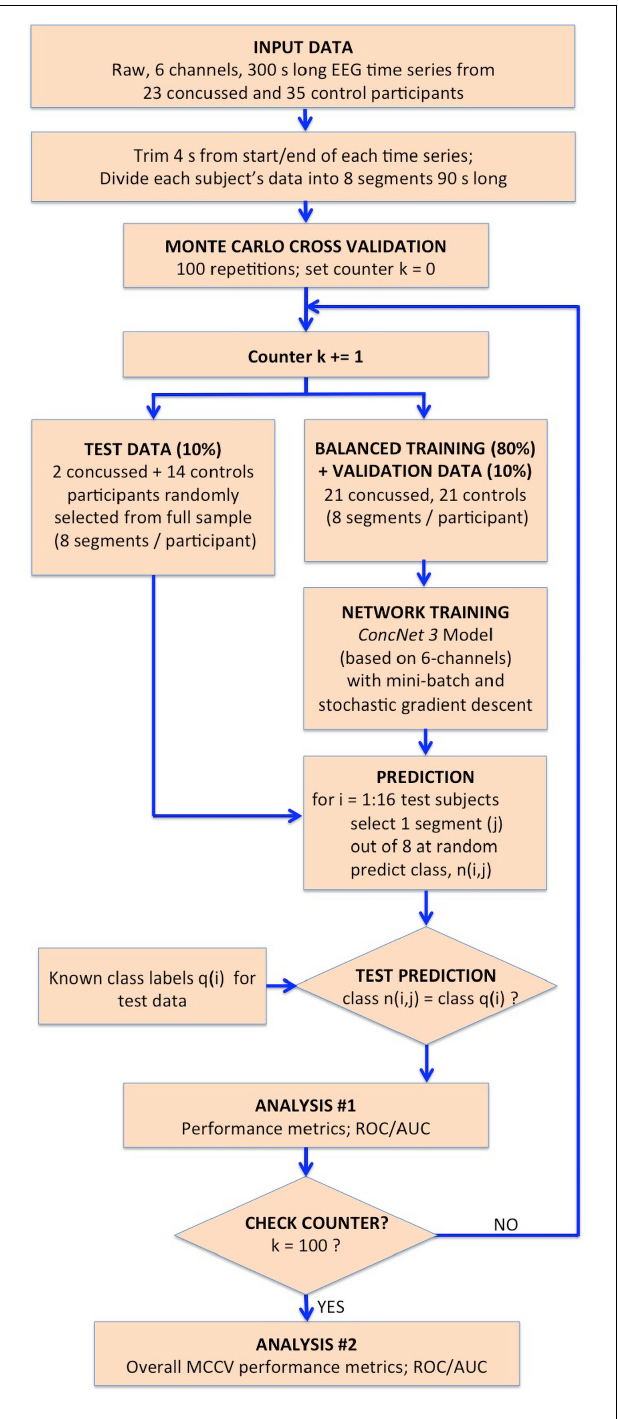
FIGURE 3 | Flowchart illustrating the procedure followed for the MCCV tests in Stage II to compare the performance of ConcNet 3 using only 6-channel data against that of ConcNet 2 , which used 64-channel data. As shown, a new dataset was created which contained data for only the six top scoring channels identified in Stage I for all the participants (23 concussed and 35 controls). These data were trimmed and segmented into eight segments for each participant. The dataset was then split in a 80:10:10 ratio into training,